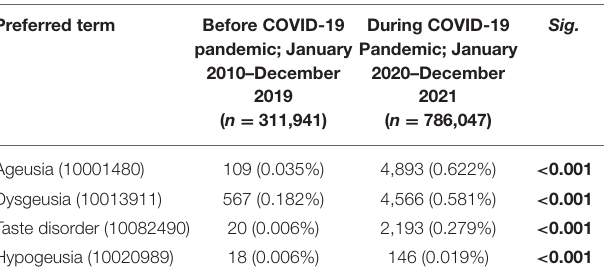
TABLE 6 | Taste-related adverse events reported after all vaccines in the United States, January 2010–December 2021 (CDC;